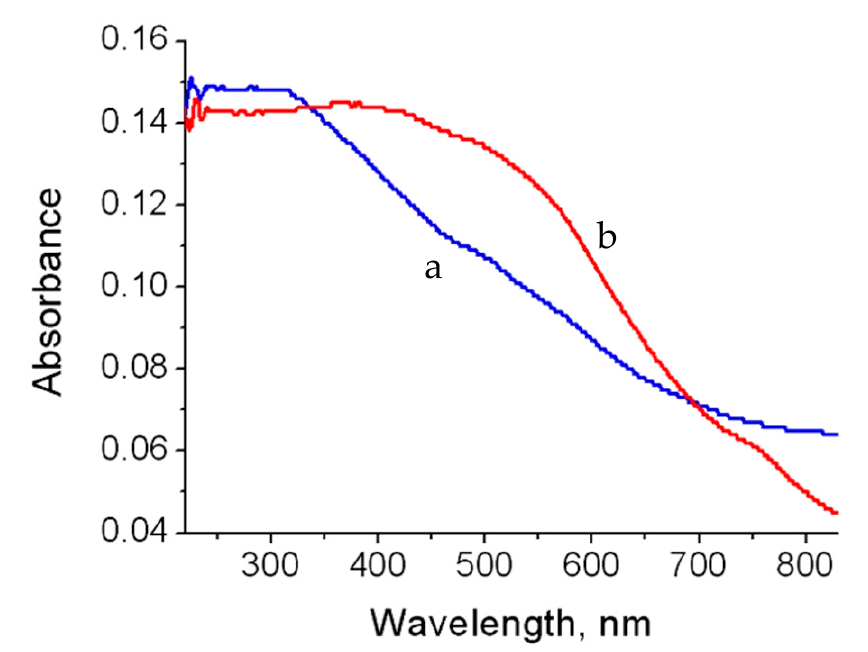
Figure 9. UV–Vis absorbance of: ( a ) BT2-600 and ( b ) BT1-600.